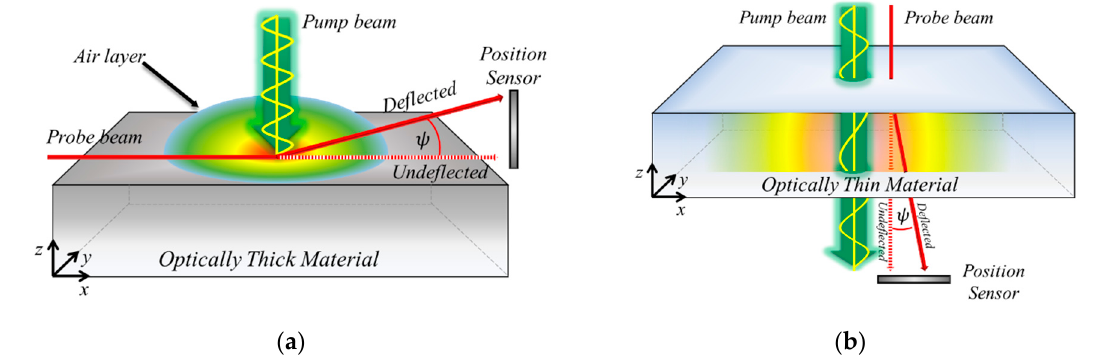
Figure 1. Photothermal deflection method types. ( a ) Mirage deflection method. ( b ) Collinear deflection method.